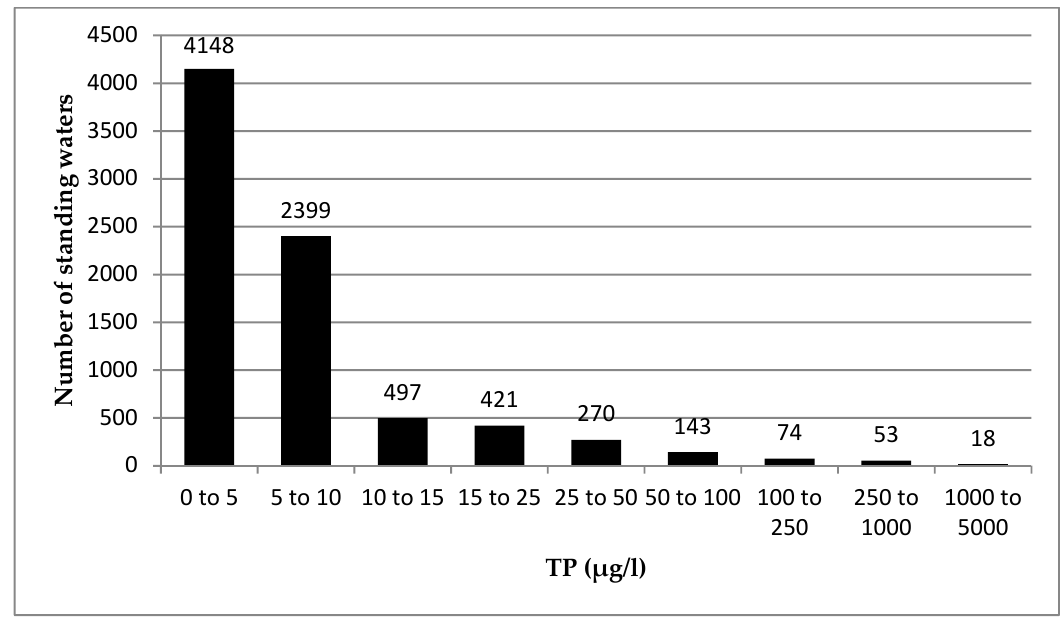
Figure 5. Frequency distribution of modelled TP concentrations in 8030 standing waters throughout Scotland (based on data from 2014). Note that seven standing waters were calculated to have zero TP concentration and are not shown above.